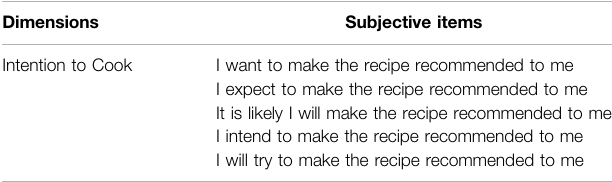
TABLE 3 | Subjective questionnaire adapted from (Conner et al., 2002) to measure users ’ intention to